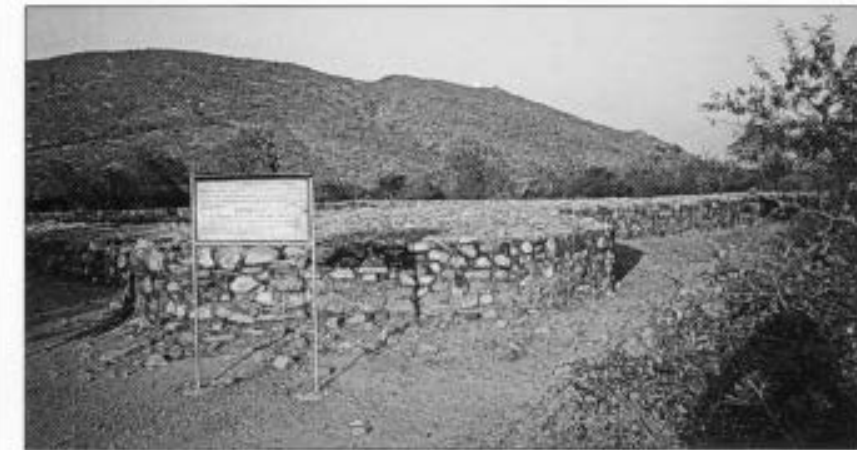
Figure 4 "Bimbisara's jail"; the structure is almost certainly the remains of a Buddhist monastery of the first millennium AD. golden age. They defined this golden age as the period in which Hinduism's Vedic